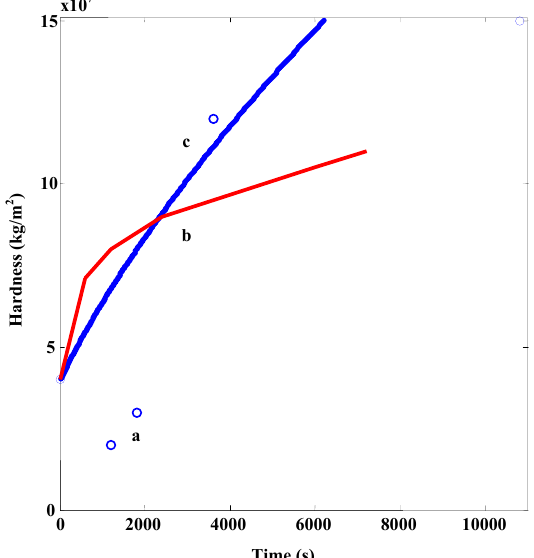
Fig. 6 . Hardness changes versus time at ball milling process: a) Experimental data [23], b) Maurice et al. model [23], c) This paper